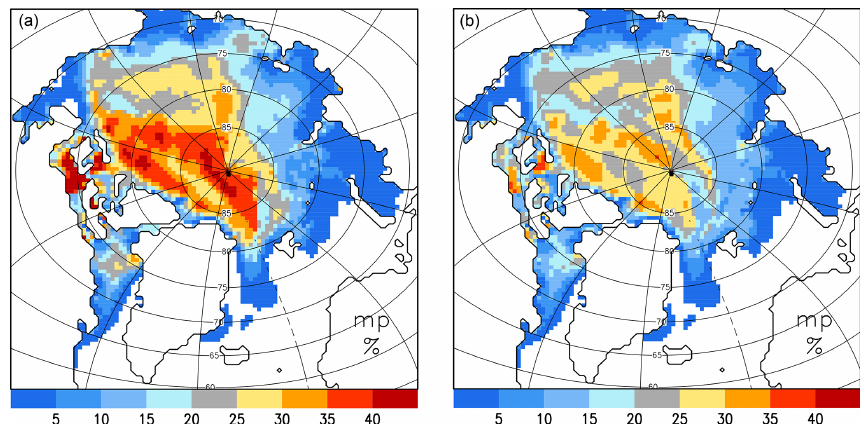
Figure 6. Impact of reduced retained meltwater fraction on simulated melt pond area fraction in July 2012: (a) CICE-default and (b) CICE- mw.